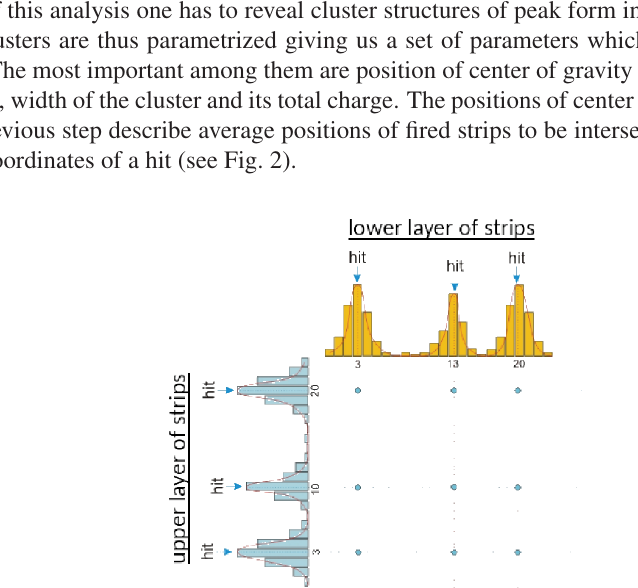
Figure 2. Schematic interpretation of the reconstruction algorithm